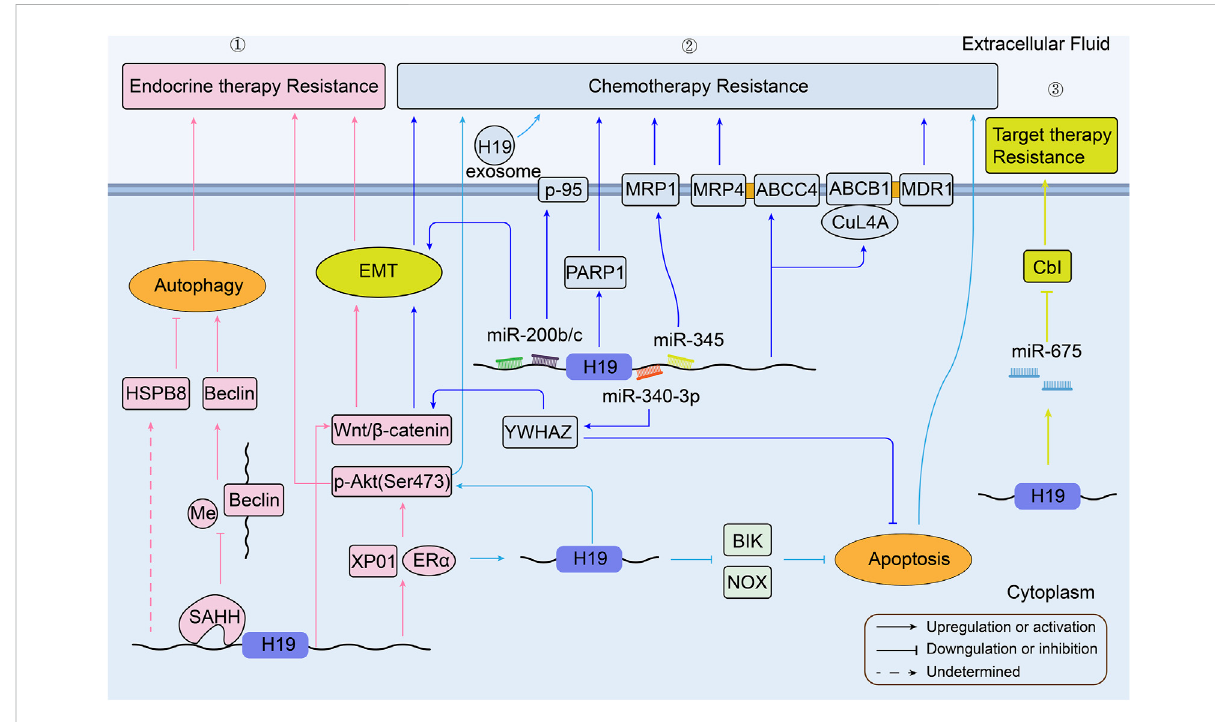
FIGURE 2 Overview of the role of H19 in modulating breast cancer therapy resistance. ① H19 related pathways in BC endocrine therapy resistance; ② H19 related pathways in BC chemotherapy resistance; ③ H19 related pathways in BC targeted therapy resistance (BC, breast